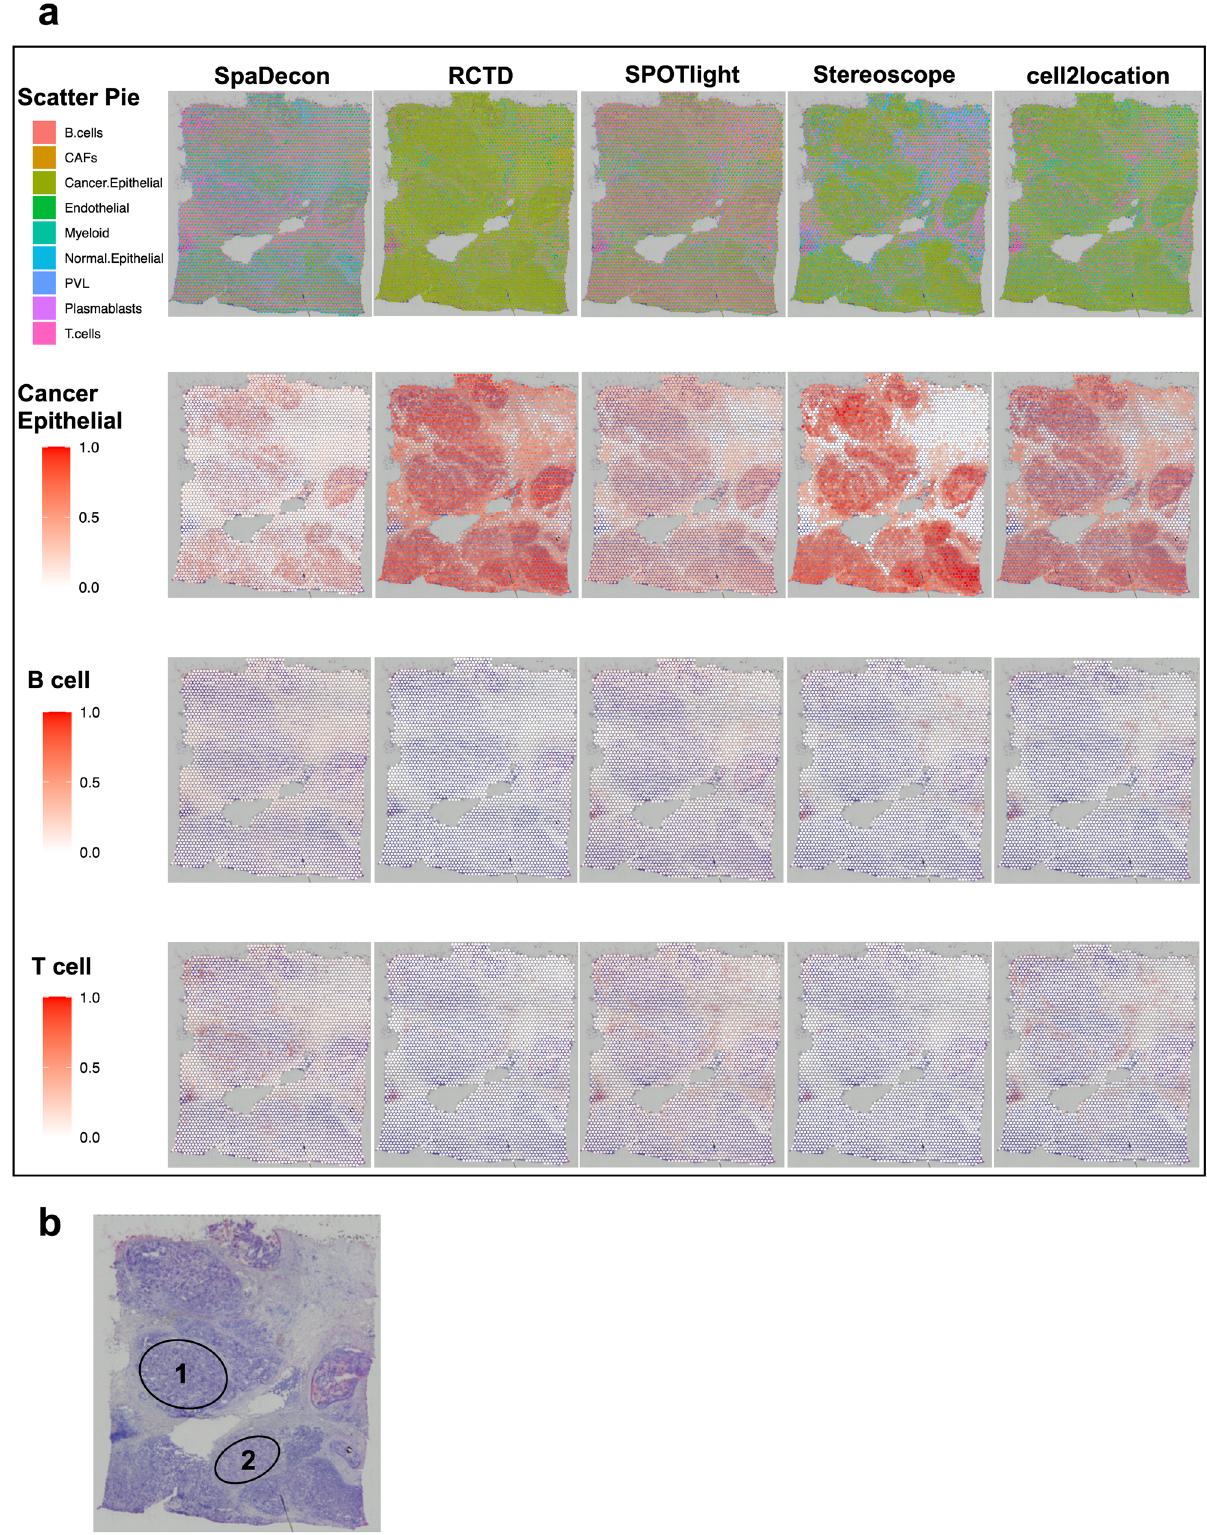
Fig. 3 Cell-type deconvolution results for 10X Visium human breast cancer (block A section 1) data. a Scatter pie plots displaying the cell-type proportion estimates of SpaDecon, RCTD, SPOTlight, Stereoscope, and cell2location at each spot, along with heatmaps showing the estimated distributions of cancer epithelial, B, and T cells. b Low-resolution histology image of breast cancer tissue section from which Visium data were obtained.